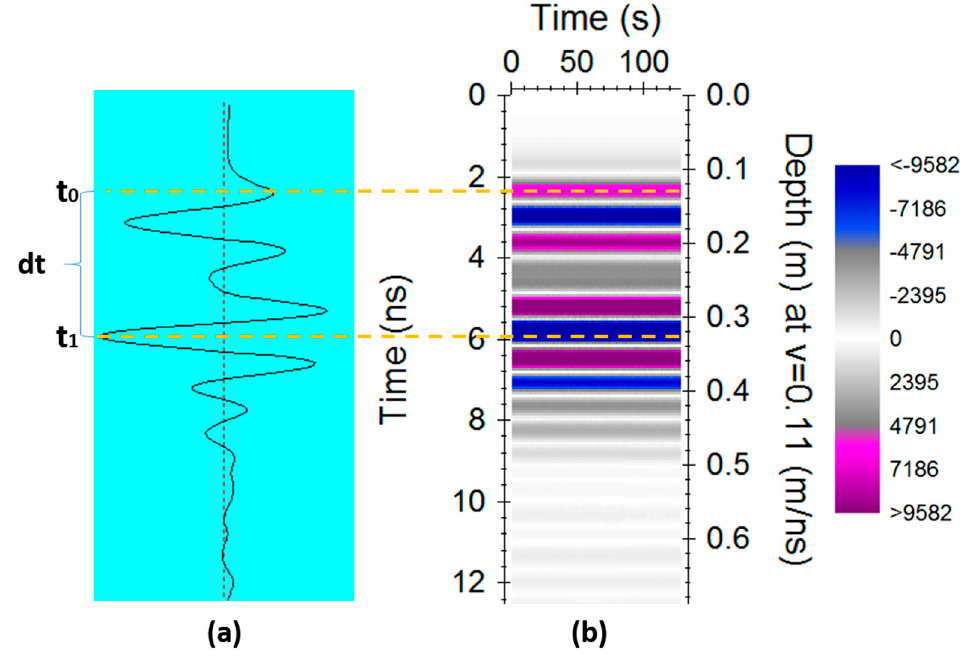
Figure 5. GPR section of calibration of the soil box experiment; the amplitude scale is on the right. ( a ) Specific wiggle trace; ( b ) GPR profile of static measurement. The upper orange line is time zero (t 0 ), and the lower orange line is the reflection from the metal bottom (t 1 ).